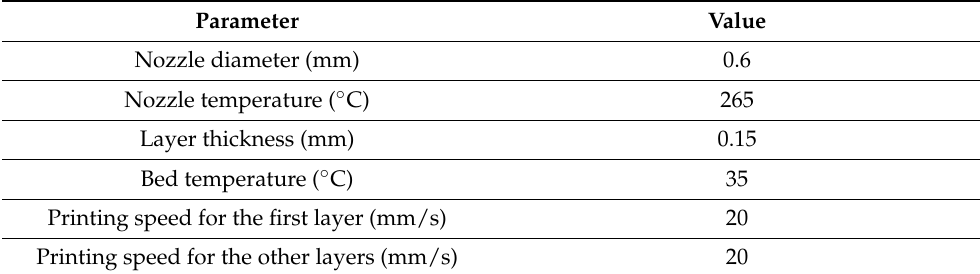
Table 2. 3D printing process